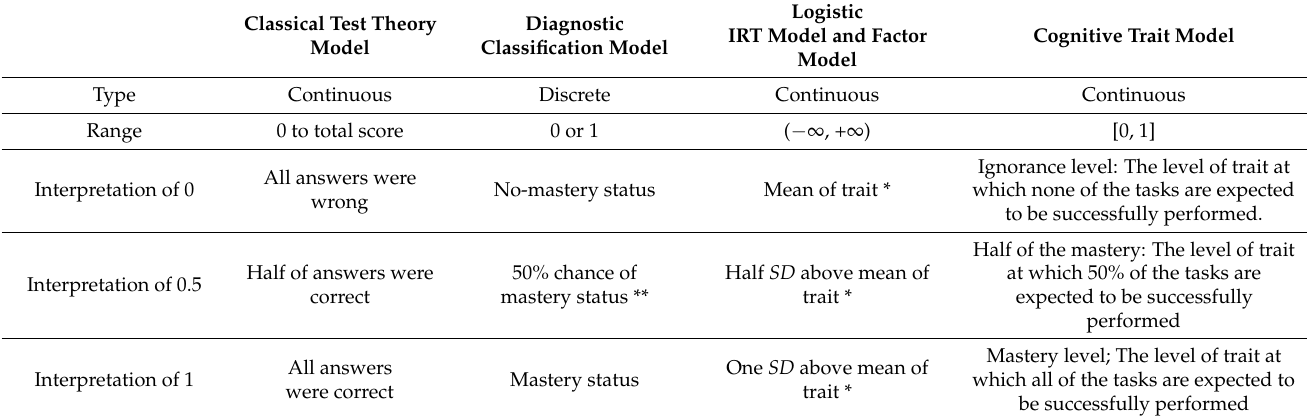
Figure 3. 3-Parameter Cognitive Trait Model Item Characteristic Curves over different α values (5, 10, 15, 20, 25) and γ values (0, 0.05, 0.1, 0.15, 0.2) when β = 0.5. Table 1. Trait Level Interpretations over Different Measurement Models.